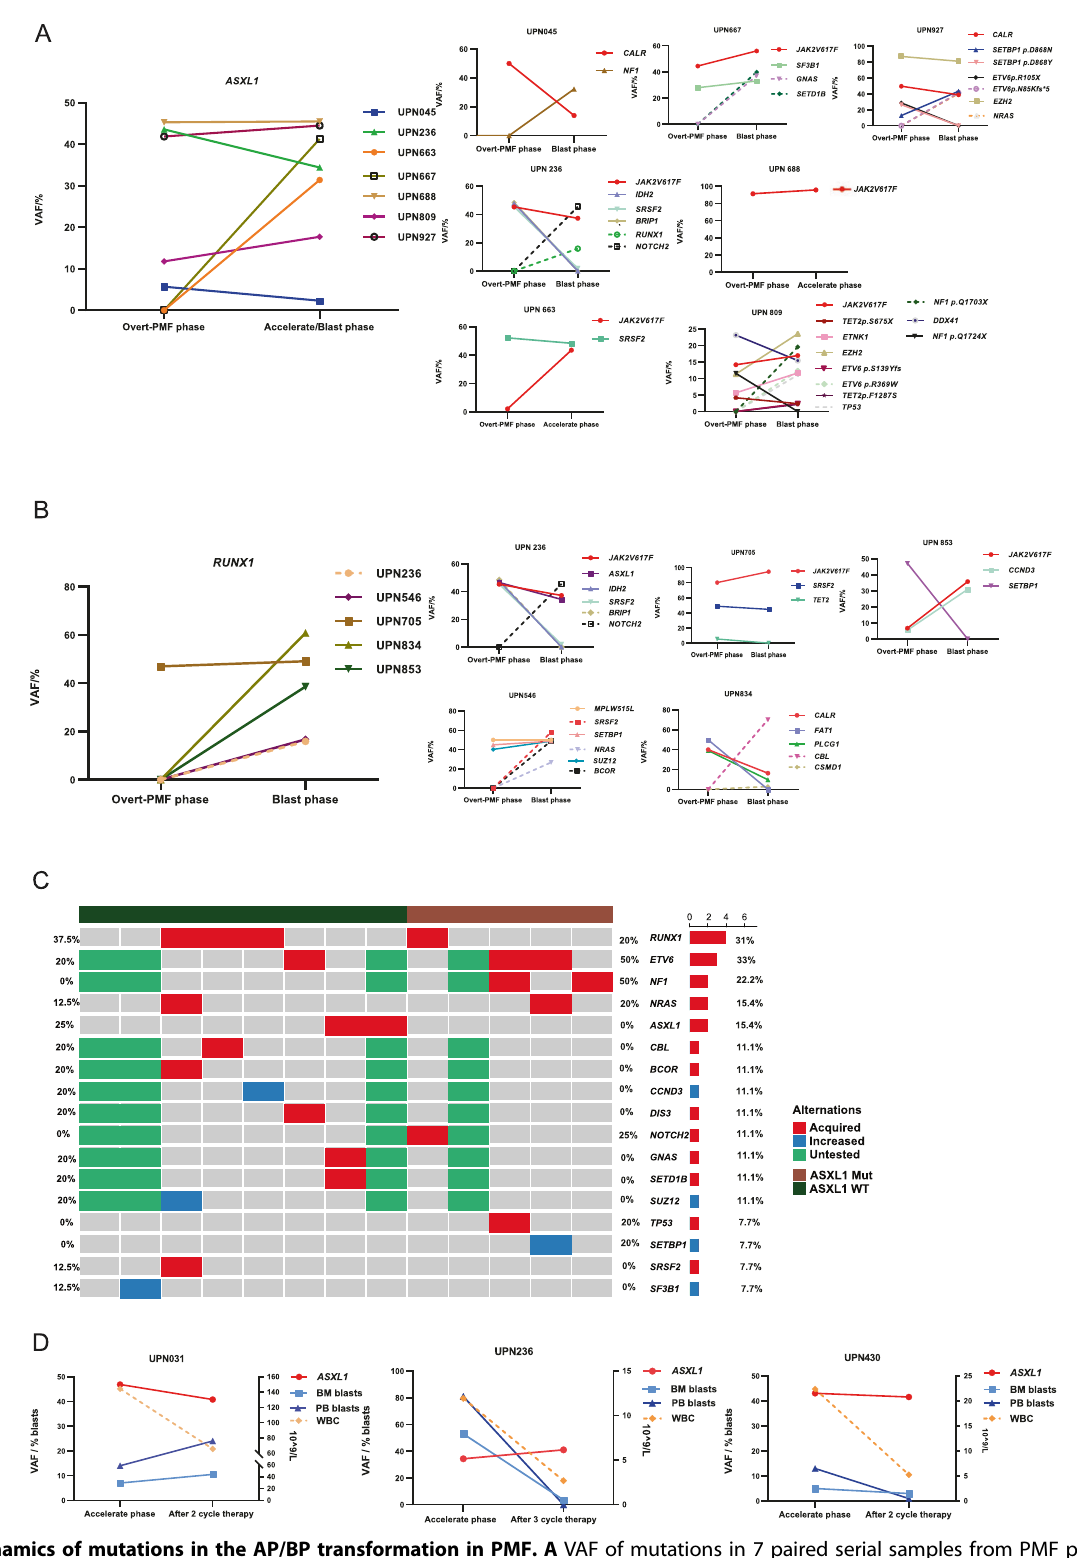
Fig. 2 Dynamics of mutations in the AP/BP transformation in PMF. A VAF of mutations in 7 paired serial samples from PMF patients with ASXL1 mutation. B VAF of mutations in 5 paired serial samples from PMF patients with RUNX1 mutation. In ( A ) and ( B ), the left panel showed the VAF of ASXL1 or RUNX1 mutation and the right panel showed the VAF of other mutations in each patient. C The number and proportion of patients with newly acquired and VAF-increasing mutations during the AP/BP transformation were indicated in the hot plot. Newly acquired mutations were depicted in red and VAF-increasing mutations (>10%) were depicted in blue, and untested genes were depicted in green. Patients with and without ASXL1 mutation in Overt-PMF were labeled in brown and blackish green, respectively. D VAF of ASXL1 mutation, percentage of peripheral blood/bone marrow blasts as well as white blood cell counts before and after HMA therapy in